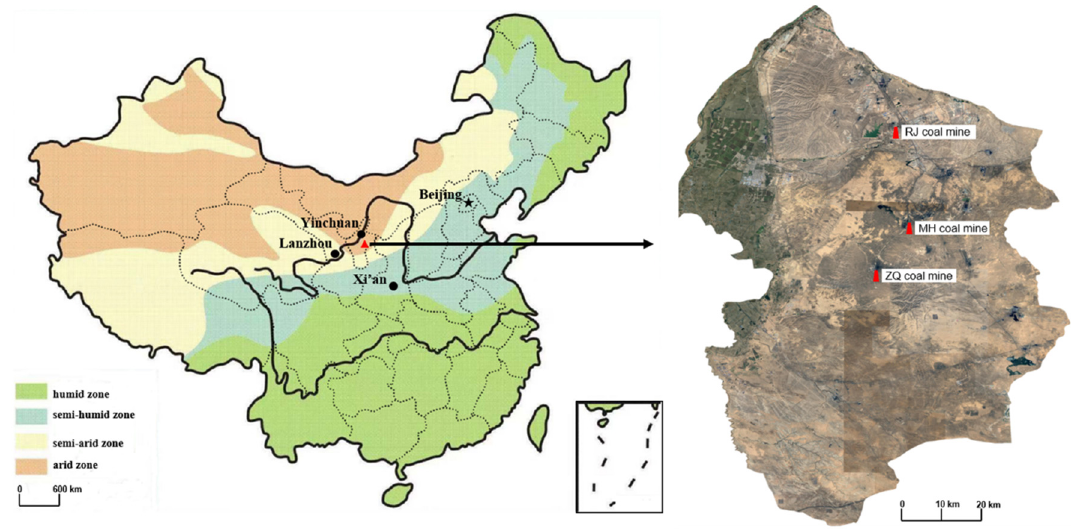
Figure 1. Location of the study area.